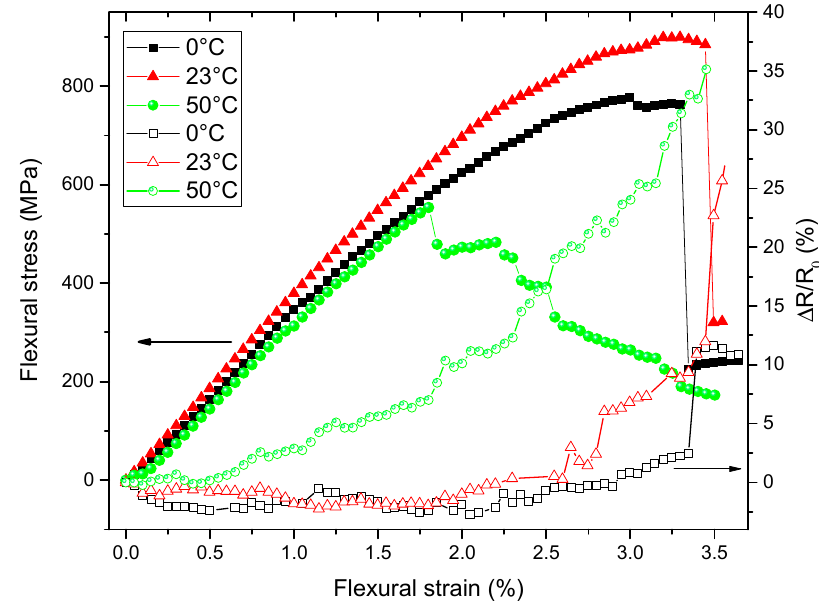
Figure 7. Piezoresistive behaviour of EP-rGO-GF composites under flexural conditions at three different temperatures (0 °C, 23 °C, and 50 °C). Full symbols : applied stress, open symbols : Δ R/R 0 values.